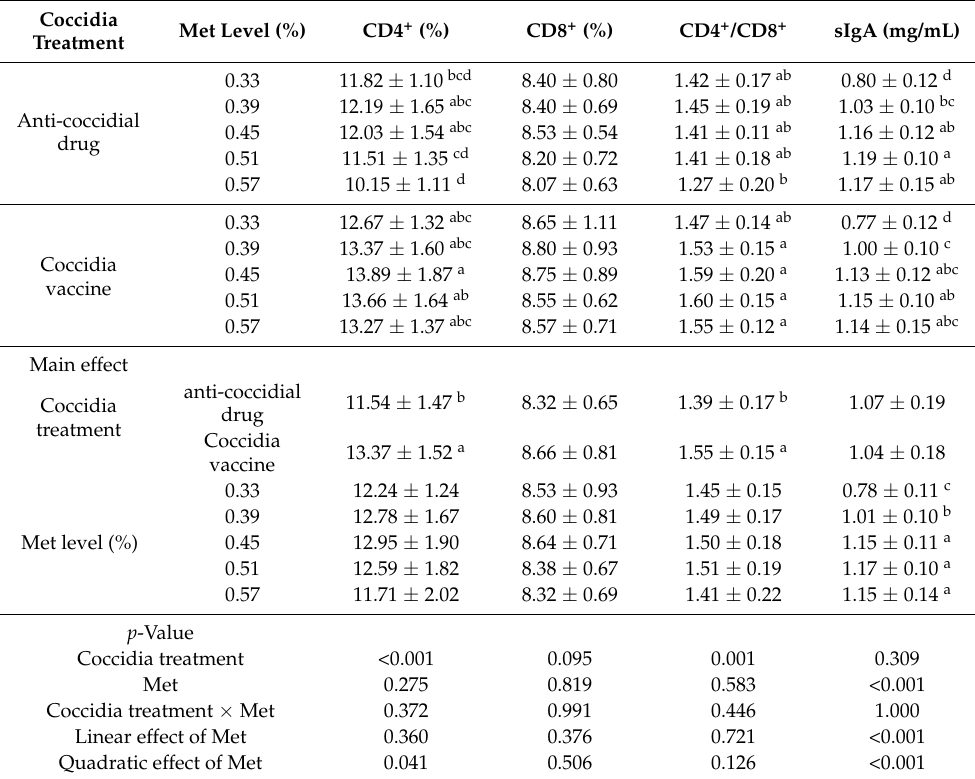
Table 7. Effect of different treatments on immunologic function of 1~21 d partridge shank broilers. Coccidia